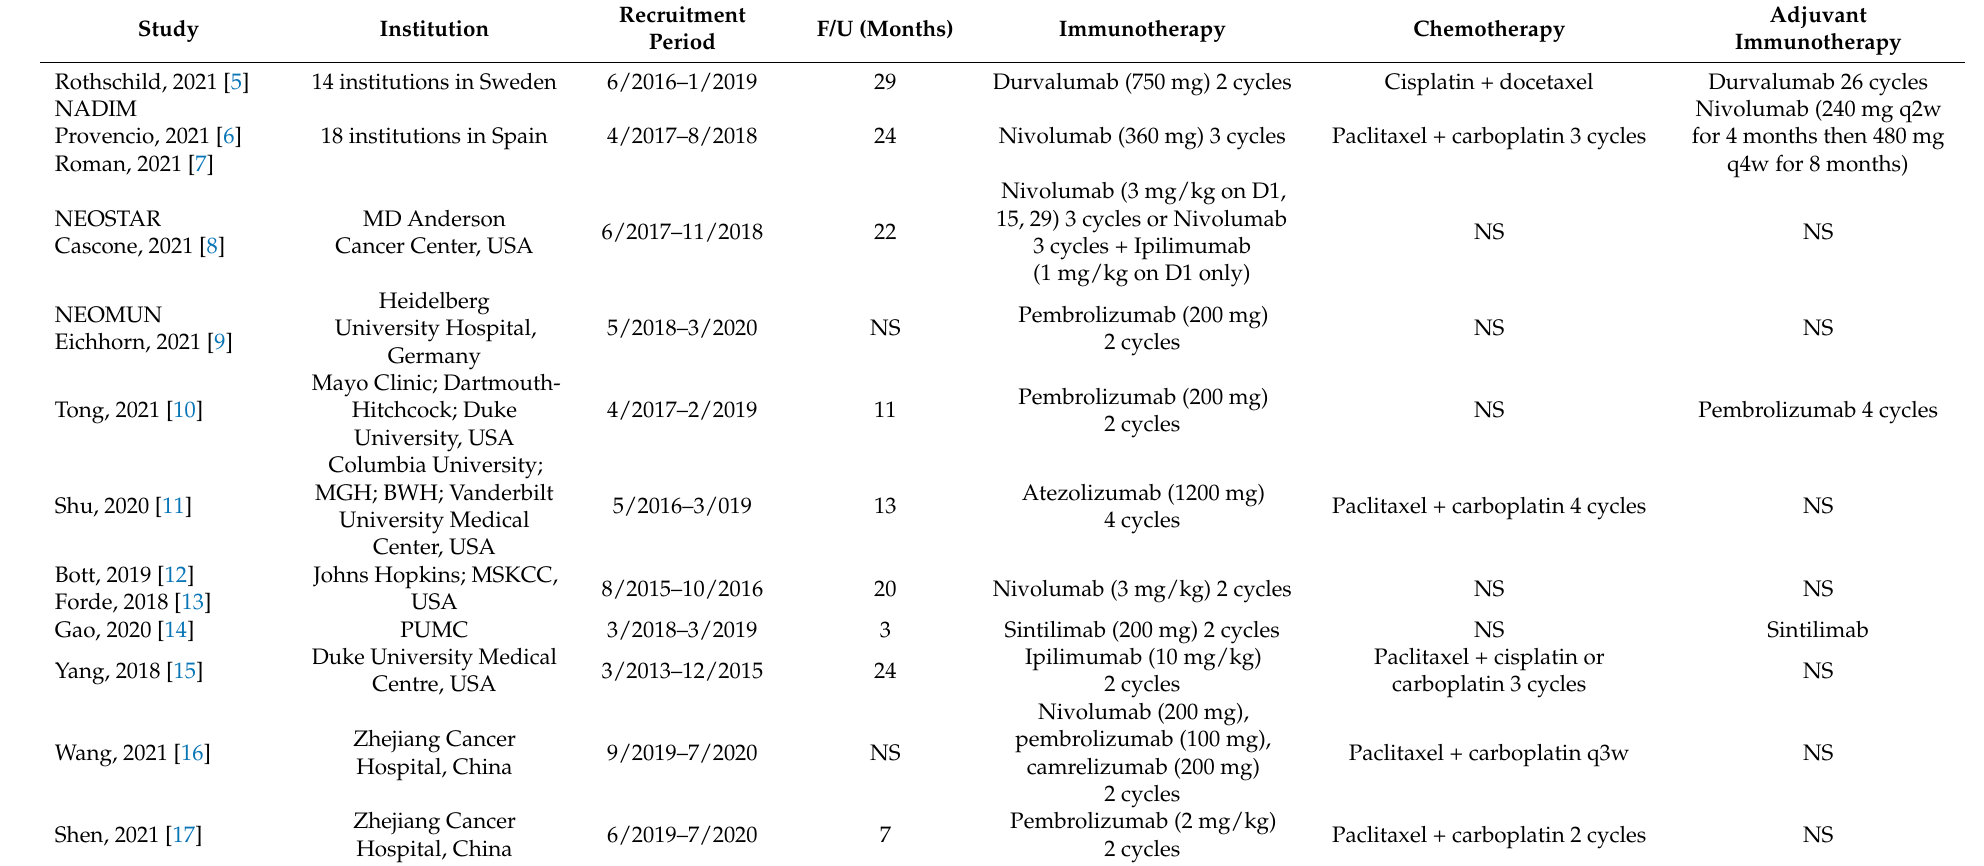
Table 1. Study characteristics of trials on neoadjuvant immunotherapy for patients with resectable non-small cell lung